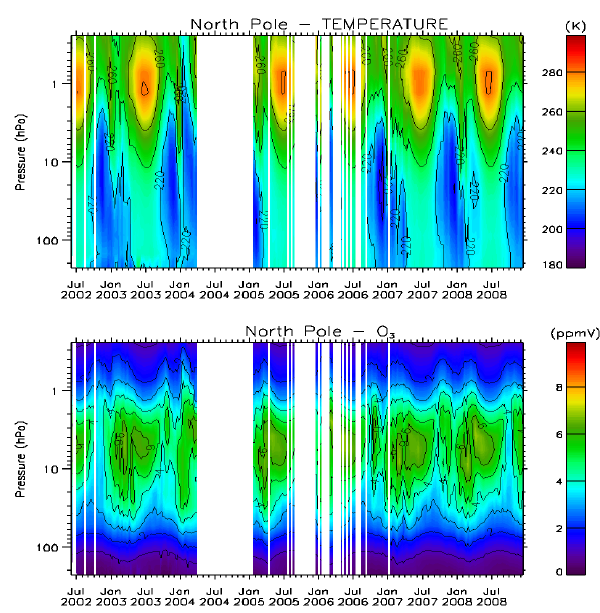
Fig. 15. Time series of 10-days means of temperature and ozone in the Arctic region (65 ◦ N–90 ◦